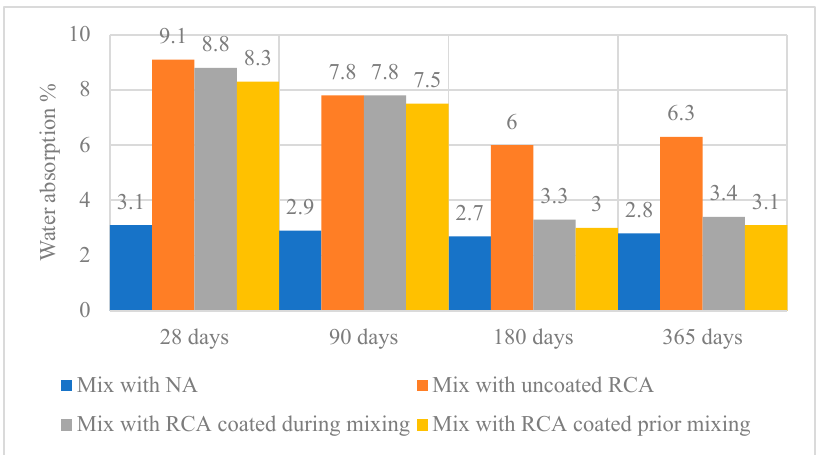
Figure 3. Effect of coated RCA on the water absorption of concrete (adapted from Junak and Sicakova [78]).